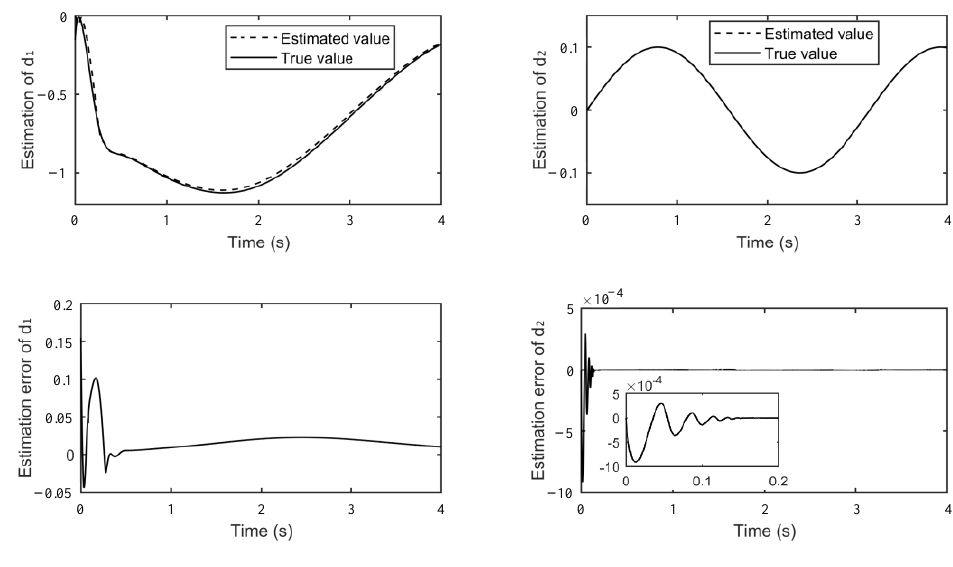
Figure 3. Estimation results of mismatched and matched disturbances.